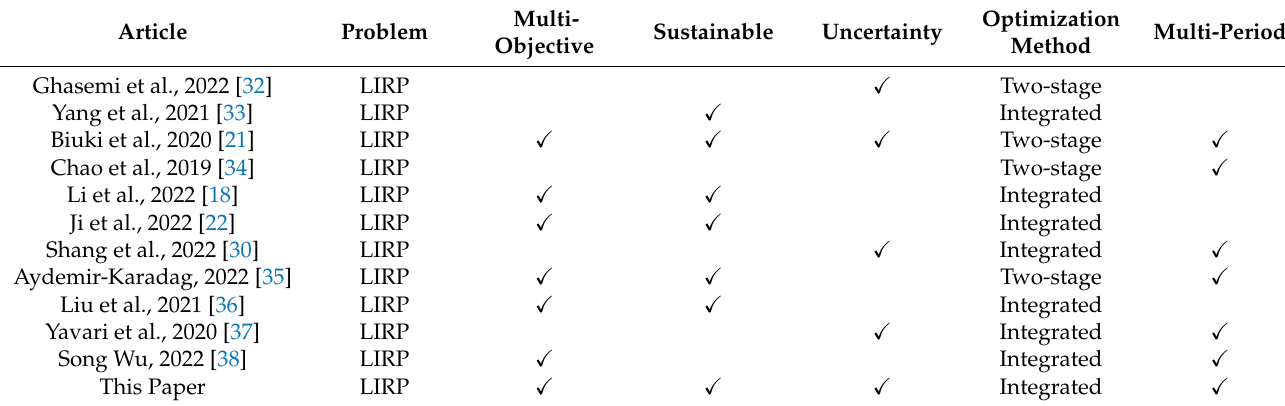
Table 1. List of referenced